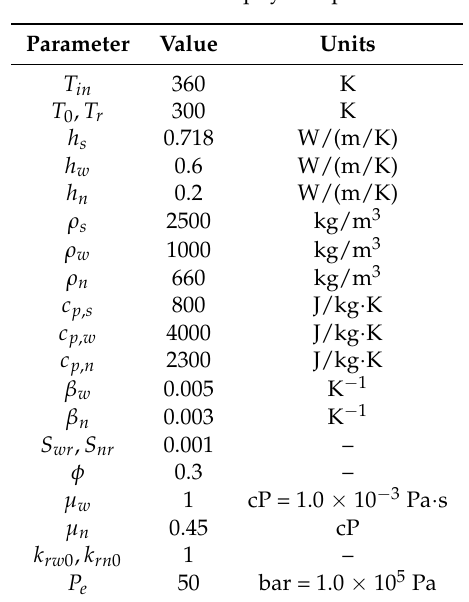
Table 1. Values of the physical